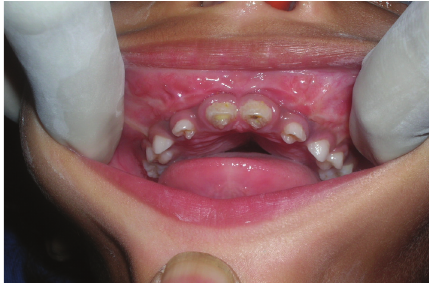
Figure 2: Intraoral view showing lobulated, bony hard swelling.